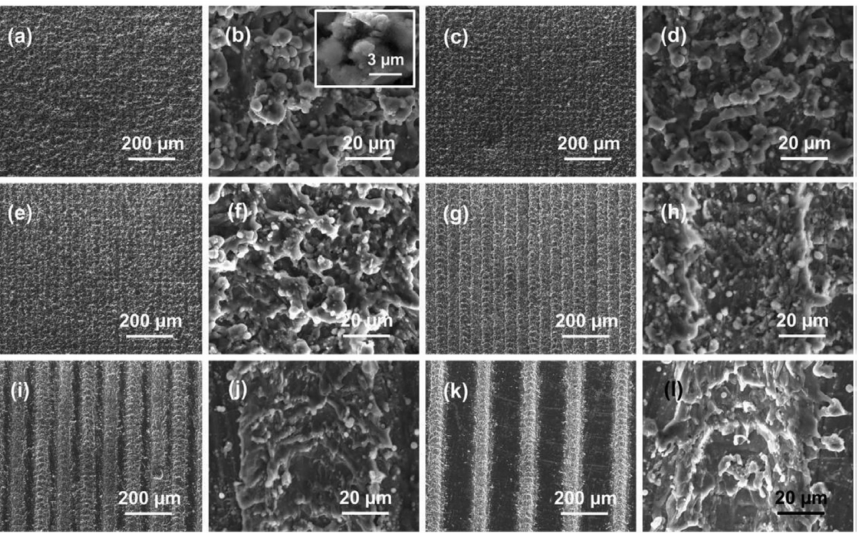
Figure 19. SEM images of Al surfaces fabricated by the nanosecond laser with different scan spacing. ( a , b ) 10 mm. ( c , d ) 20 mm. ( e , f ) 30 mm. ( g , h ) 50 mm. ( i , j ) 100 mm. ( k , l ) 200 mm. (Reprinted from [31] with permission from